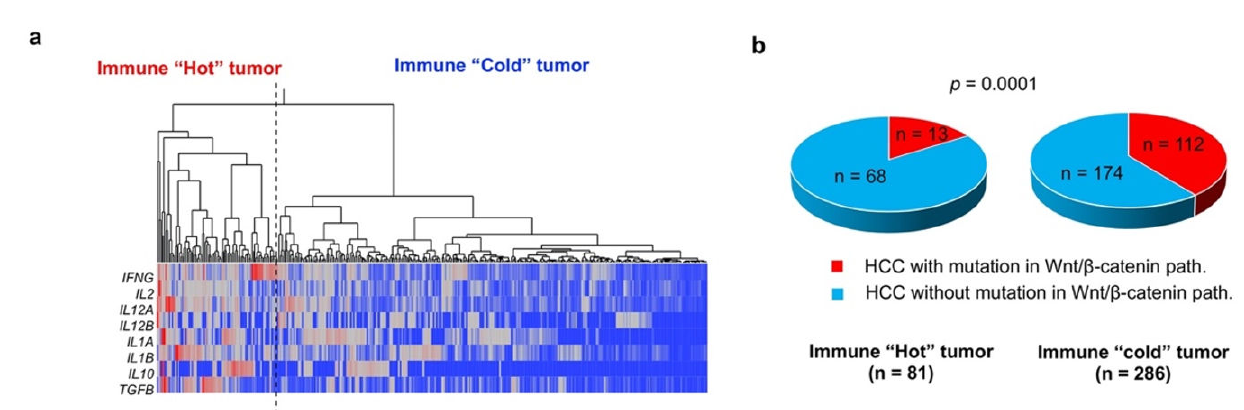
Figure 3. Tumor-infiltrating lymphocyte status and abnormal WNT/ β -catenin activation. Hierarchical cluster analysis was used to classify HCCs based on the expression of eight T cell-related cytokine mRNAs obtained from the TCGA transcriptome dataset (RNA-seq V2 RSEM) ( a ) “Immune hot” and “immune cold” refer to HCCs with high and low levels of T cell-related gene expression, respectively. Thus, “immune hot” indicates a large volume of tumor-infiltrating lymphocytes (TILs), while “immune cold” suggests that TILs are deficient. ( b ) The presence or absence of activating mutations in WNT/ β -catenin pathway genes are determined based on the presence or absence of CTNNB1, AXIN1 and APC mutations in the TCGA provisional dataset obtained. Activating mutations in the WNT/ β -catenin pathway are more frequently detected in “immune cold” HCCs than in “immune hot” tumors ( p = 0.0001). The TCGA dataset used in the present study